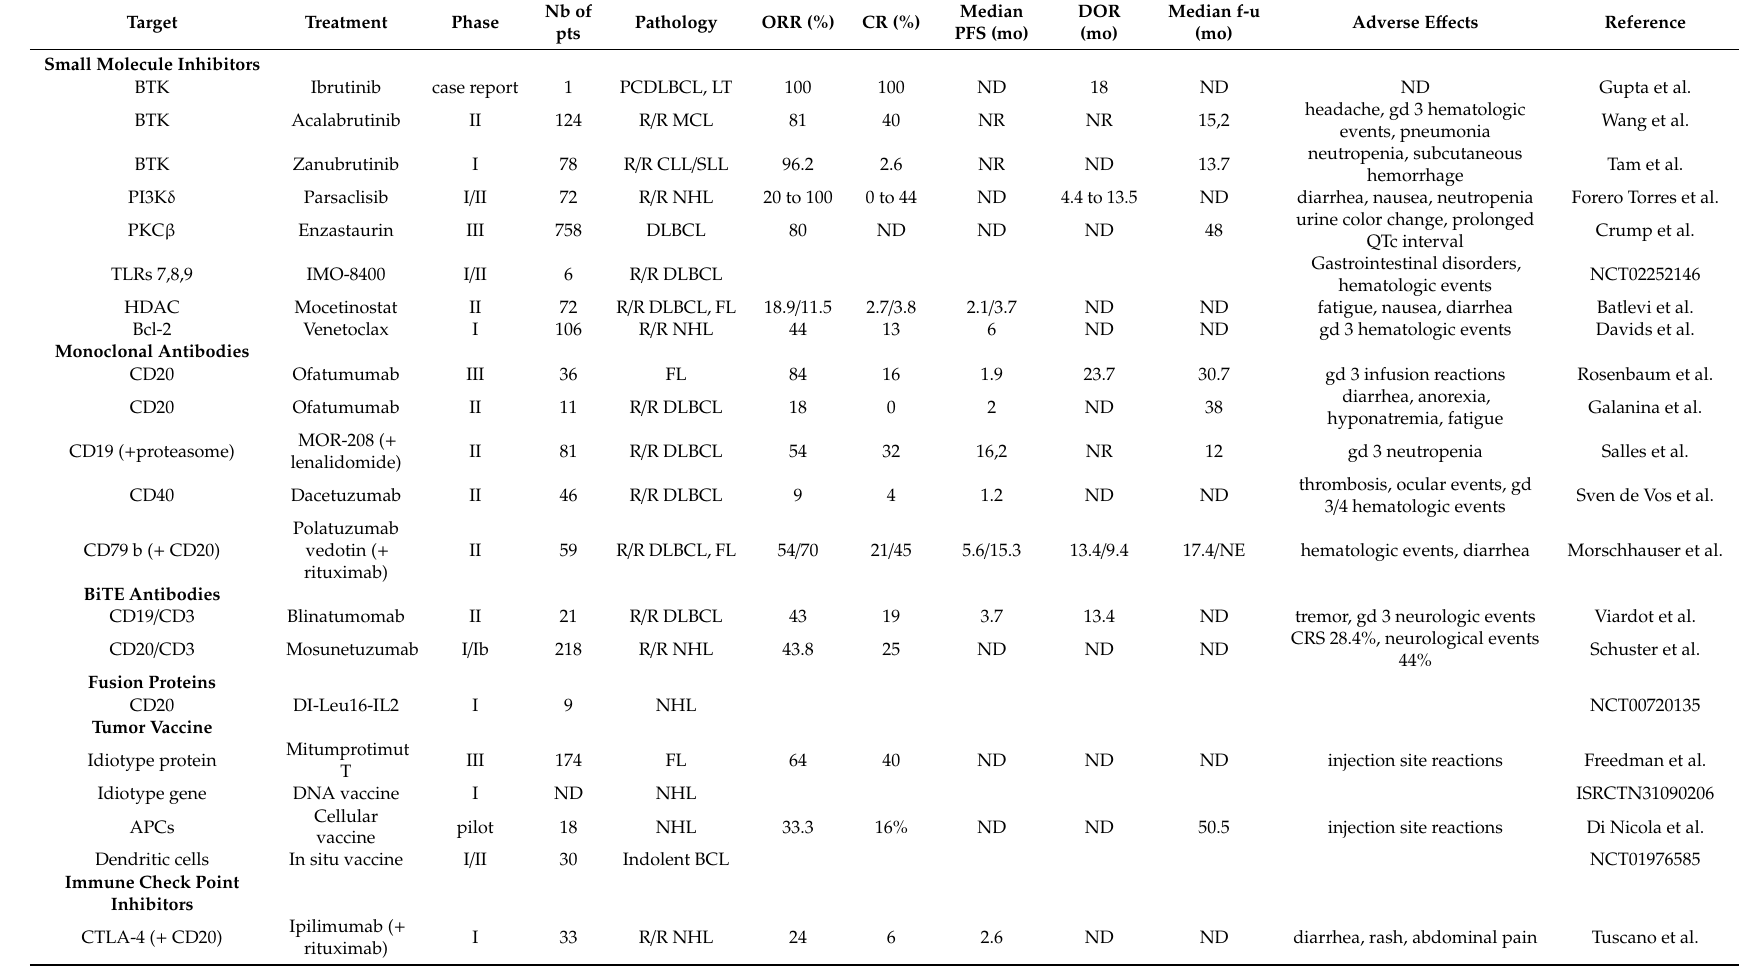
Table 1. E ffi cacy and safety of selected novel therapies in B-cell